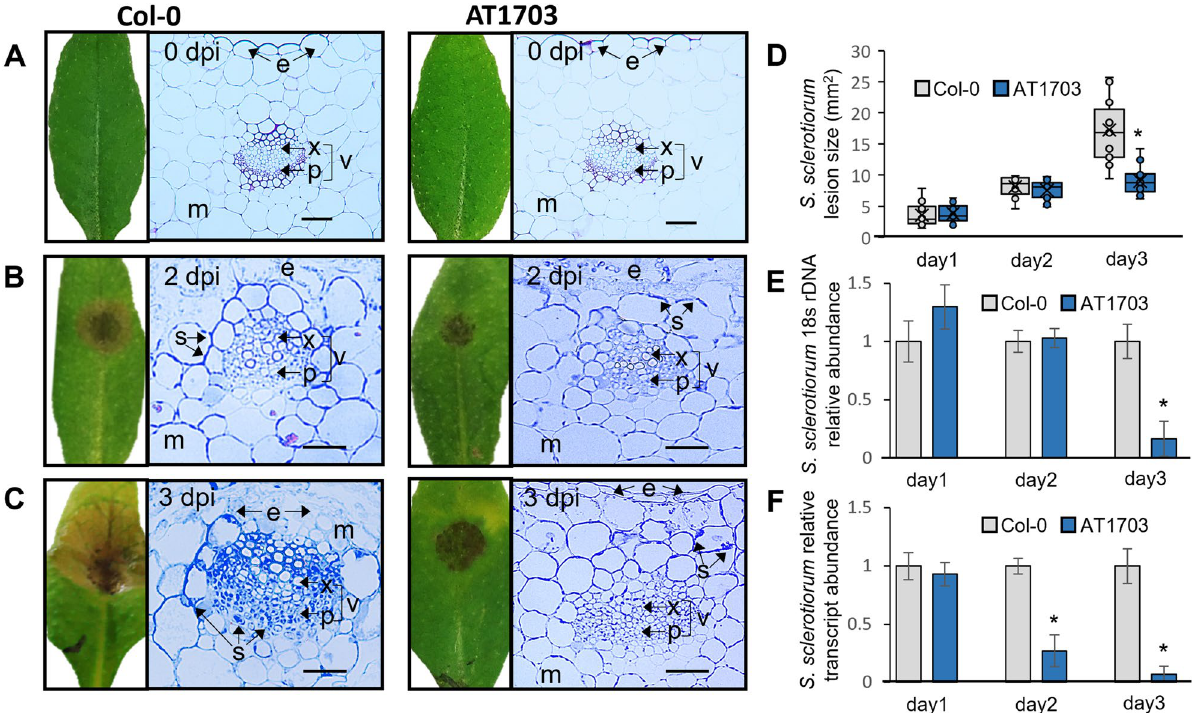
Figure 1. Whole-leaf and cross section of wild-type Col-0 and AT1703 A. thaliana uninfected control and infected with S. sclerotiorum at ( A ) 0, ( B ) 2, and ( C ) 3 days post inoculation. Five µM cross-sections generated using Leica RM2245 and stained with ( A ) toluidine blue and ( B , C ) lactophenol cotton blue. ( D ) lesion size (mm 2 ), ( E ) fungal load and ( F ) target transcript reduction in Col-0 and T3 AT1703 leaves infected with S. sclerotiorum . A. thaliana inoculated with 1 × 10 6 µL ascospore solution and measured at 2- and 3-days post inoculation. ( D ) Sample size of n = 15 leaves per line were measured using ImageJ software and normalized to wild-type Col-0 leaves for lesion measurements. Error bars represent standard error and significance was determined using a Student’s t -test (p < 0.05). * = significance. ( E ) Fungal load quantified using relative abundance of 18S S. sclerotiorum rDNA and calculated using ∆CT against wild-type Col-0. Each line consists of three biological replicates, each containing three infected A. thaliana leaves. ( F ) Target transcript abundance calculated using the ∆∆CT method with Sac7 as a reference gene. Each line consists of three biological replicates, each containing three infected A. thaliana leaves for ( E ) and ( F ). Error bars represent standard error. Scale bars = 50 µm. e, epidermis; m, mesophyll; x, xylem; p, phloem; v, vasculature; s, S. sclerotiorum.